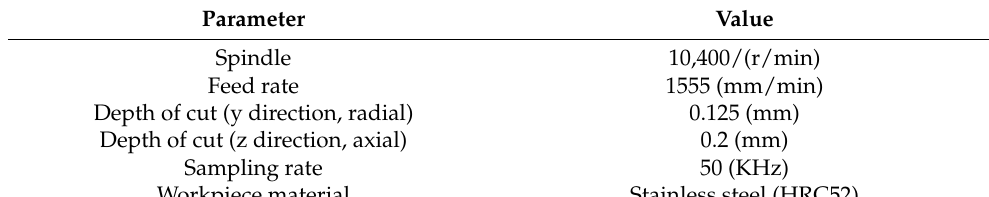
Table 2. Experimental processing parameters.